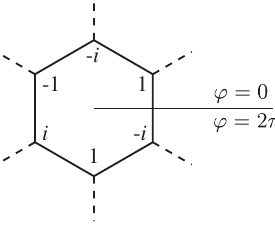
FIG. 10. Wave function of the zero-energy bound state of the Haldane model disclination with n Ω ¼ 0 , Φ ¼ 1 = 2 , t ¼ 1 , and λ ¼ 0 . 2